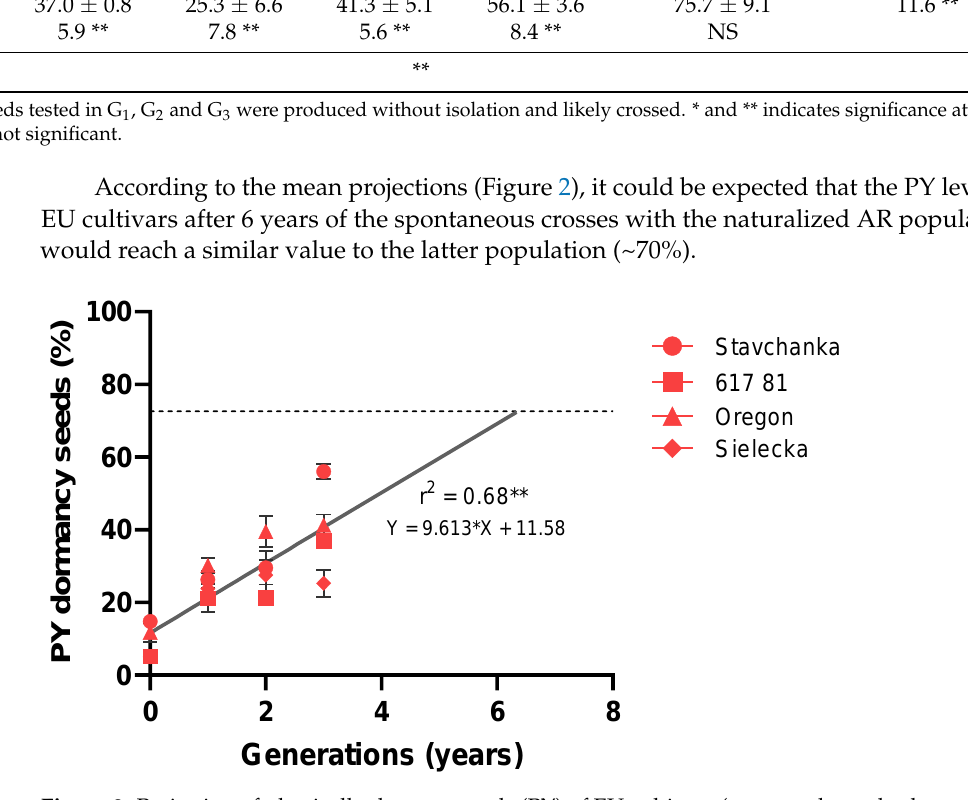
Figure 2. Projection of physically dormant seeds (PY) of EU cultivars (mean and standard error) as a function of generations of spontaneous crosses with a naturalized AR population. (** p < 0.01) A faster rate of PY break was observed under summer compared to winter field conditions, due to the high temperatures (>9.8 ◦ C) [11] increasing PY release (Figure S2). After 6 months and one year of burial, the PY levels ranged from 0–46% and 0–22%, respectively, depending on the initial PY (Figure 3a). Completely eliminated seedbank persistence (0% PY) after one year was observed when the initial PY level was lower than 14% (Figure 3b, Table